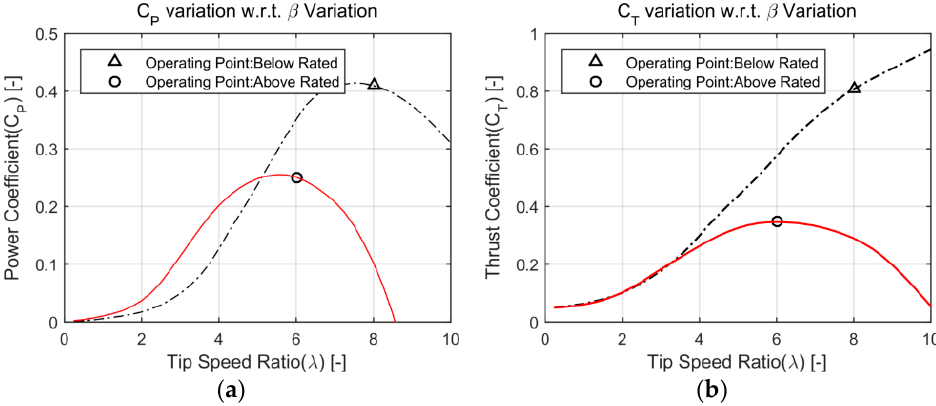
Figure 3. Changes in wind turbine operating condition by blade pitch angle adjustment: ( a ) power coefficient variation; ( b ) thrust coefficient variation.